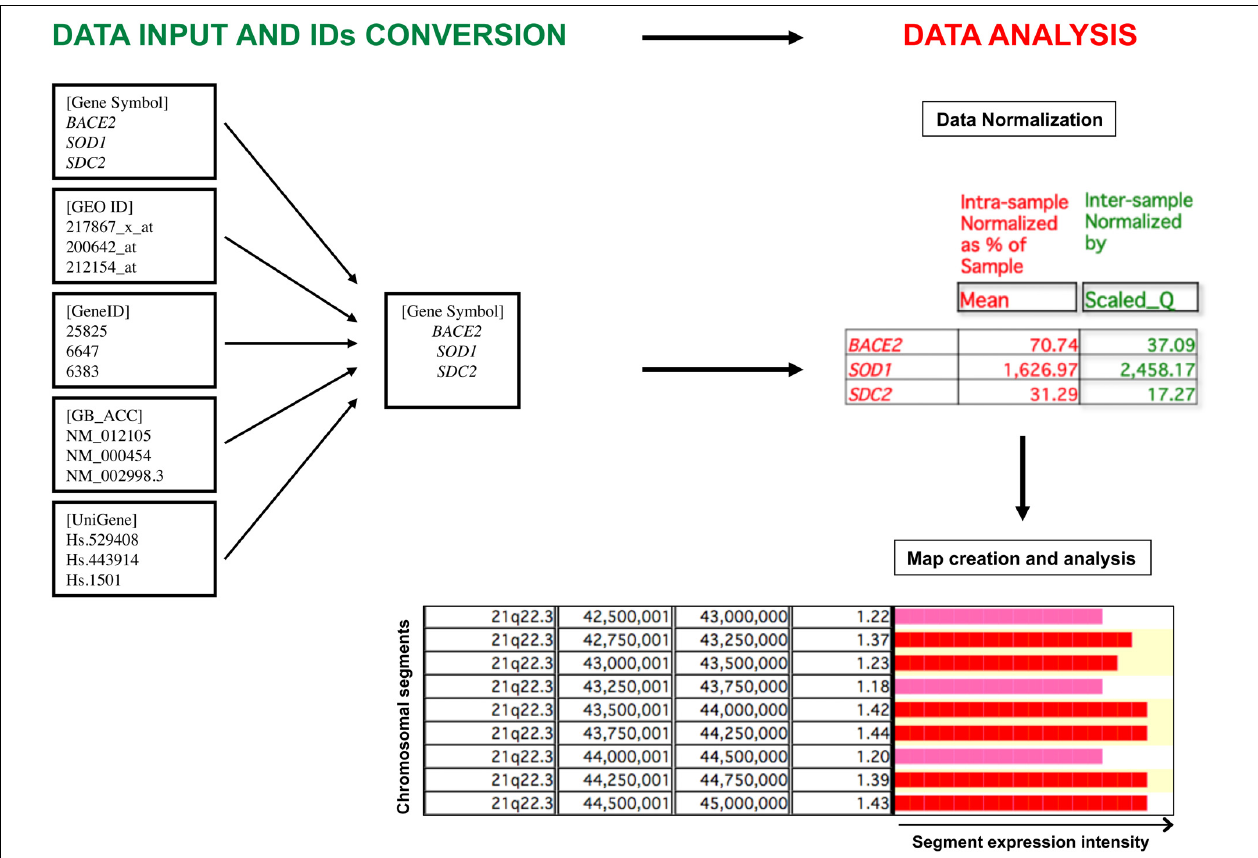
FIGURE 1 | Graphic representation of the TRAM software workflow. The software allows the import and analysis of gene expression profile datasets in tab-delimited text format. Gene expression values are assigned to individual loci following conversion of all types of gene identifiers (IDs) into official gene symbols, and submitted to an intra- and inter-sample normalization. The value for each locus is the mean value of all available normalized values for that locus. The expression ratio obtained from the comparison of two different conditions is graphically displayed for each chromosomal segment, expressed as ratio of the mean of the expression values of the loci included in that segment. Over- and under-expressed regions are then determined following statistical analysis.